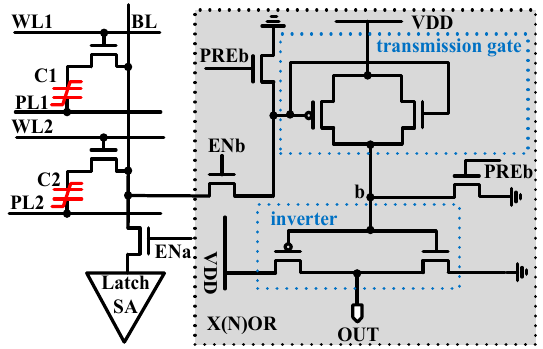
Figure 4. The X(N)OR circuit is based on the 1T1C-type ferroelectric capacitor (FeCAP)